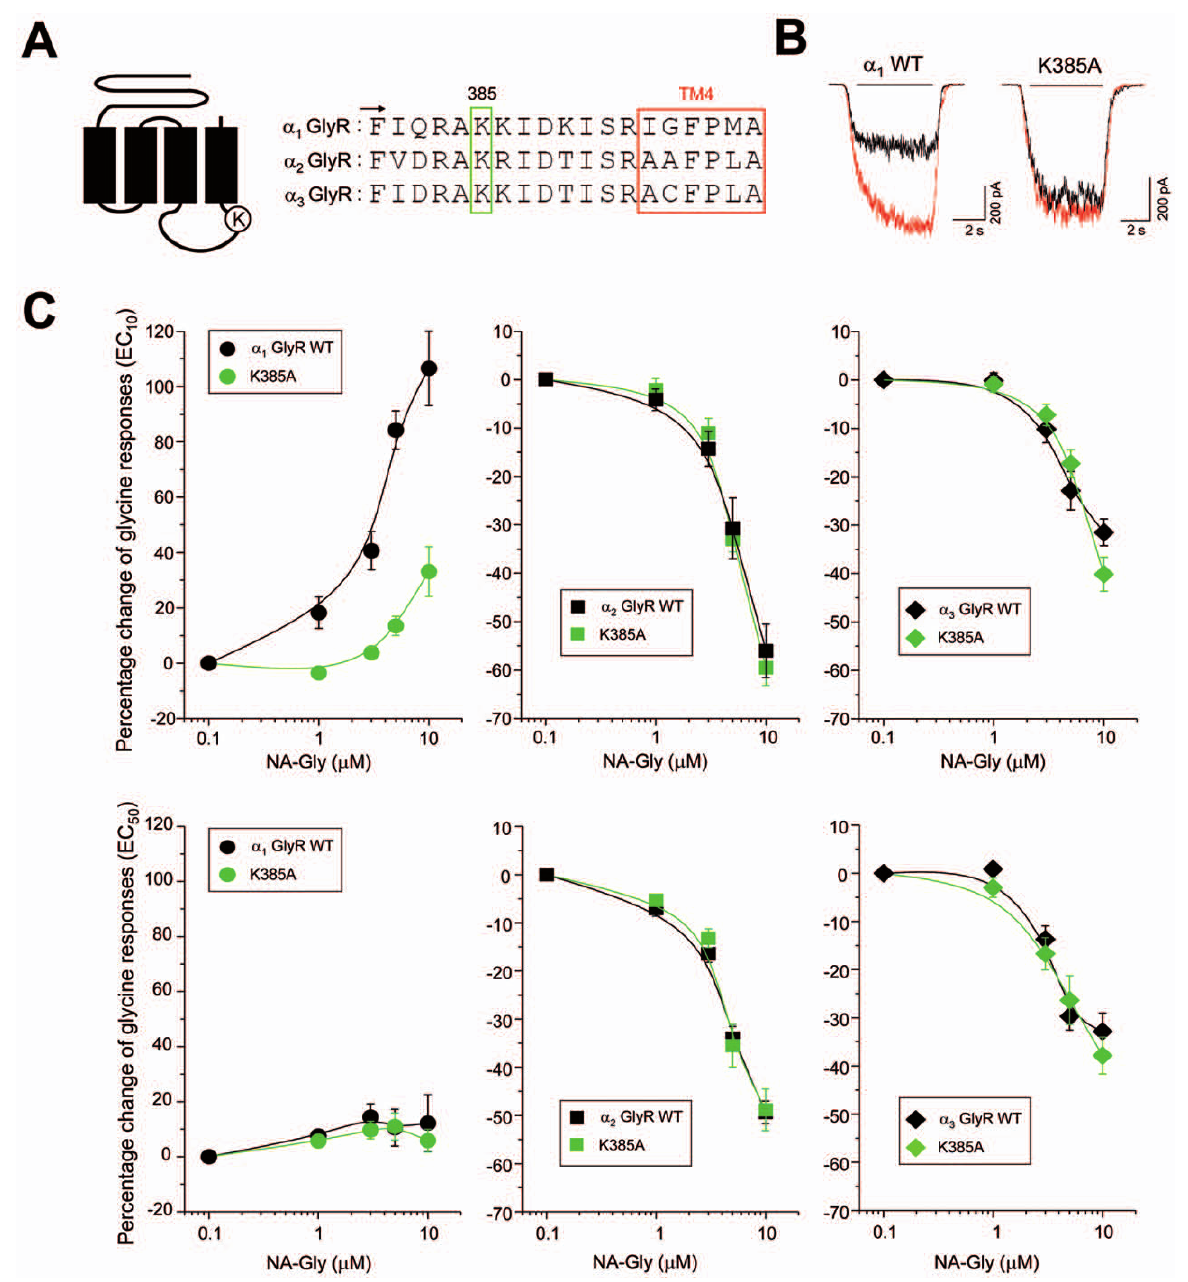
Figure 7. The positive allosteric modulation elicited by NA-Gly is influenced by a conserved lysine residue within the a 1 GlyR large intracellular loop. ( A ) The schematic receptor representation and the primary sequence alignment describe the position of the conserved intracellular K385 residue within the GlyR structure ( B ) Glycine-activated current traces from wild-type or K385A-mutated a 1 GlyRs before (black) and during the application of NA-Gly (5 m M, red) ( C ) Concentration-response curves for NA-Gly obtained from wild-type and K385-mutated GlyRs. The intracellular mutation significantly attenuated the NA-Gly-induced potentiation of a 1 GlyRs.